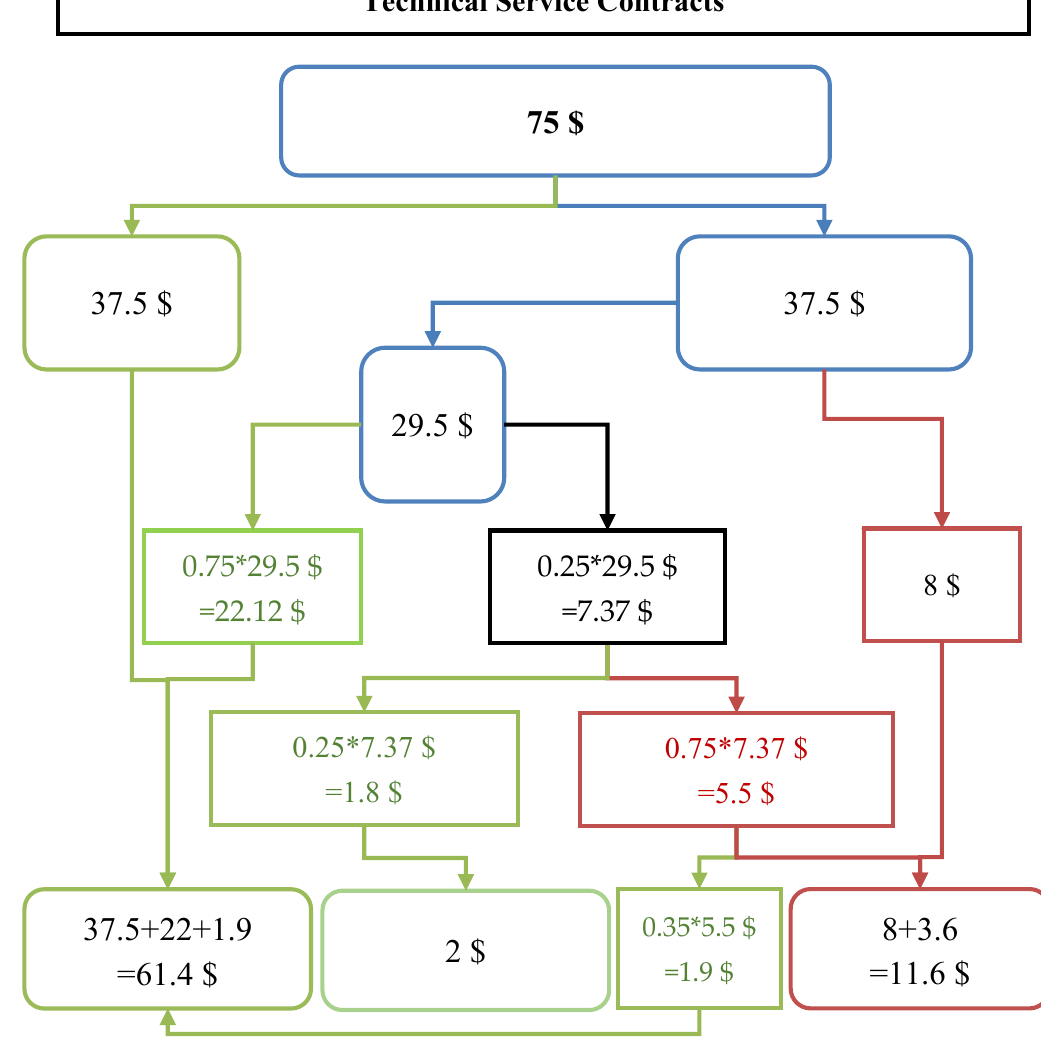
Figure 7. Calculated profit-sharing when investing in free gas.